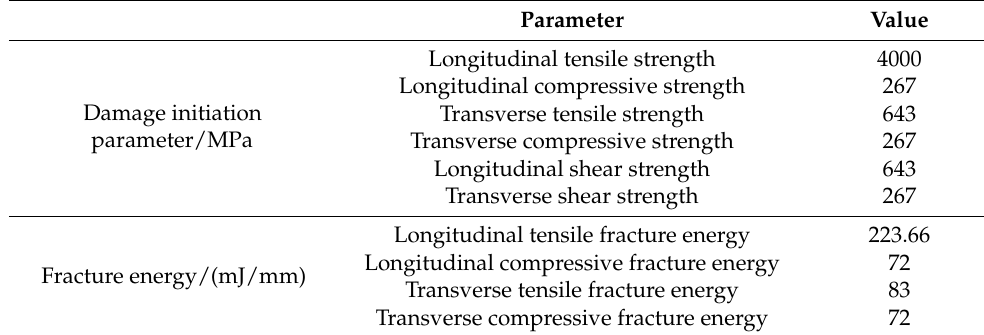
Table 6. Hashin failure criteria parameters.